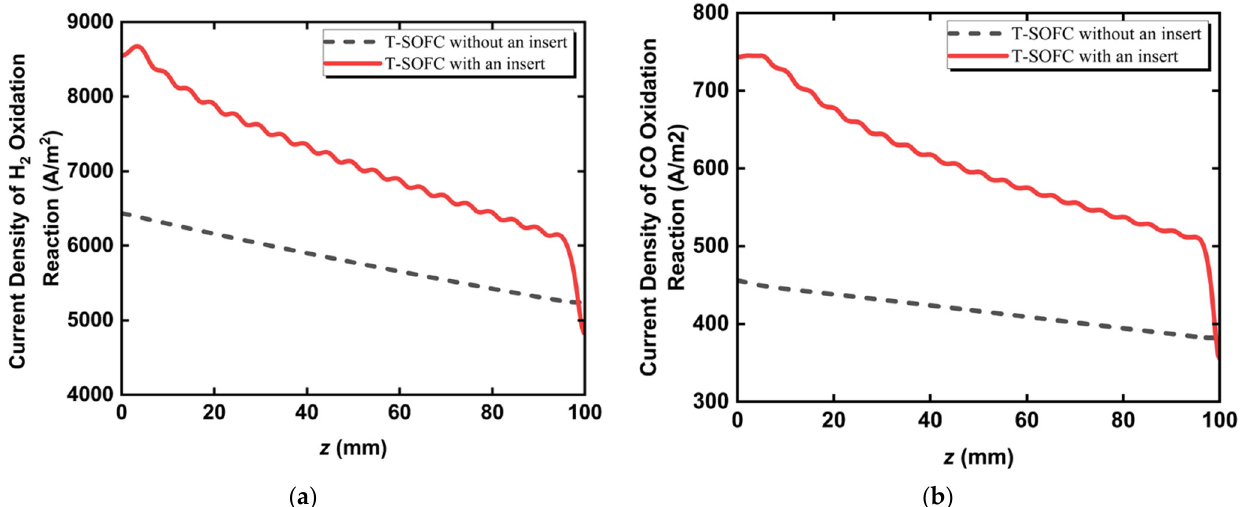
Figure 7. The axial distribution of current densities from ( a ) hydrogen electrochemical oxidation and ( b ) carbon monoxide electrochemical oxidation at the interface between the reaction and diffusion layers in tubular SOFCs with and without inserts.